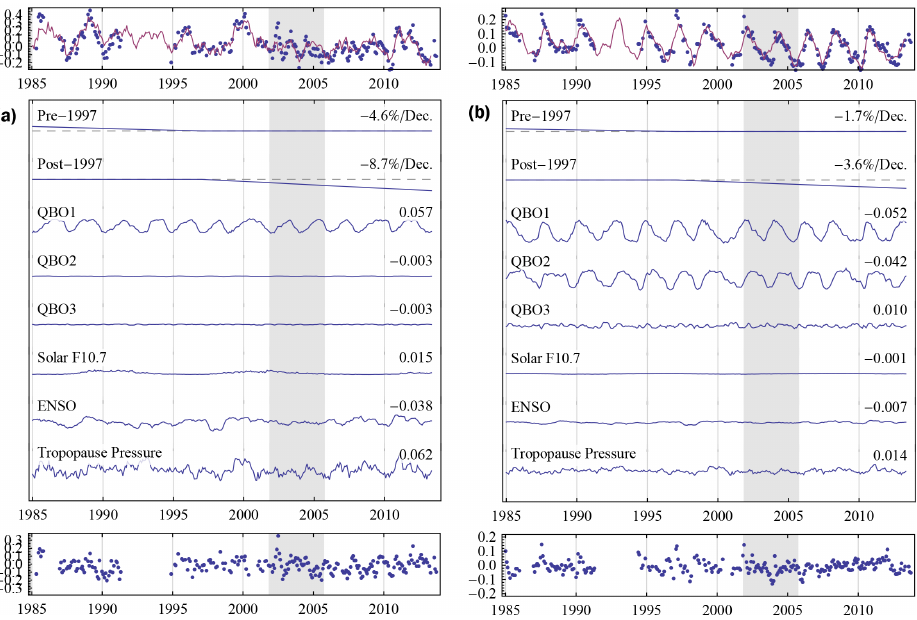
Figure 6. In each column, the uppermost panel shows the ozone anomaly in blue and resulting fit in red for a given latitude and altitude. The middle panel shows the pre- and post-1997 percent per decade linear terms, and the six non-linear basis functions multiplied by their normalized best-fit parameters (shown on the right of each curve). The basis functions are shown on the same scale as the ozone anomaly. These terms sum to form the resulting fit. The lower panel contains the residual ozone anomaly. Left: 5 ◦ S–5 ◦ N at 18.5km altitude (cf. Figs. 1a, 3a). At this location negative trends in ozone are apparent both before and after 1997 with a relatively strong correlation to tropopause pressure and ENSO. Right: 5 ◦ S–5 ◦ N at 22.5km altitude (cf. Fig. 1b, 3b) with a smaller but still negative correlation both before and after